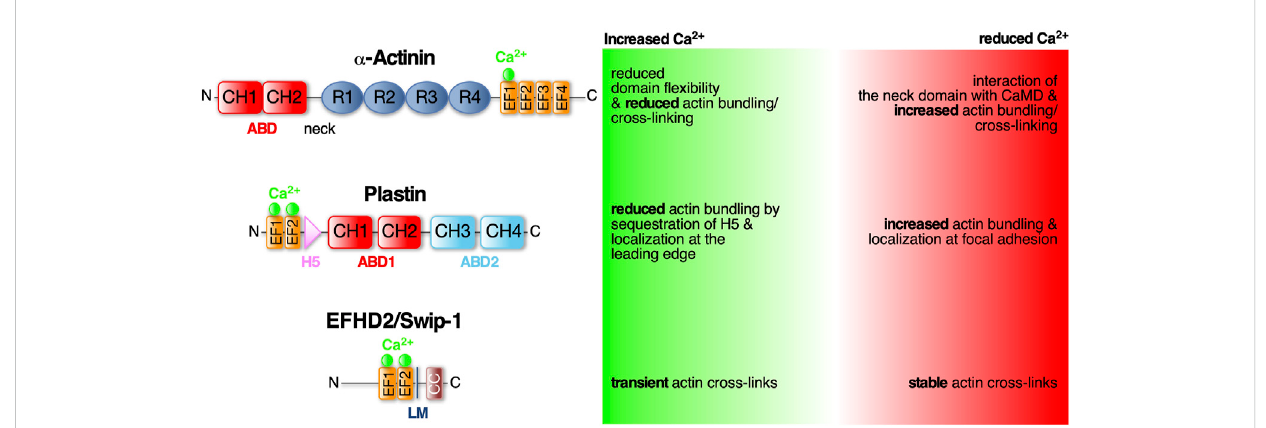
FIGURE 1 α -Actinin, Plastin and EFHD2/Swiprosin-1 — three conservedEF-hand containingactin cross-linking proteins regulated by Ca 2+ . Schematicdiagram of the protein domains of α -Actinin, Plastin and EFHD2/Swiprosin-1 and structural and functional changes in response to calcium. Domains as indicated: ABD (actin bindind domain) consists of two CH (calponin homology) domains; EF-hands (helix-loop-helix motif) that bind Ca 2+ (green spheres); R (spectrin-like repeats) facilitate dimerization of α -Actinin; LM (ligand mimic domain); CC (coiled-coil domain) facilitates dimerization of EFHD2/ Swiprosin-1; H5 ( fi th